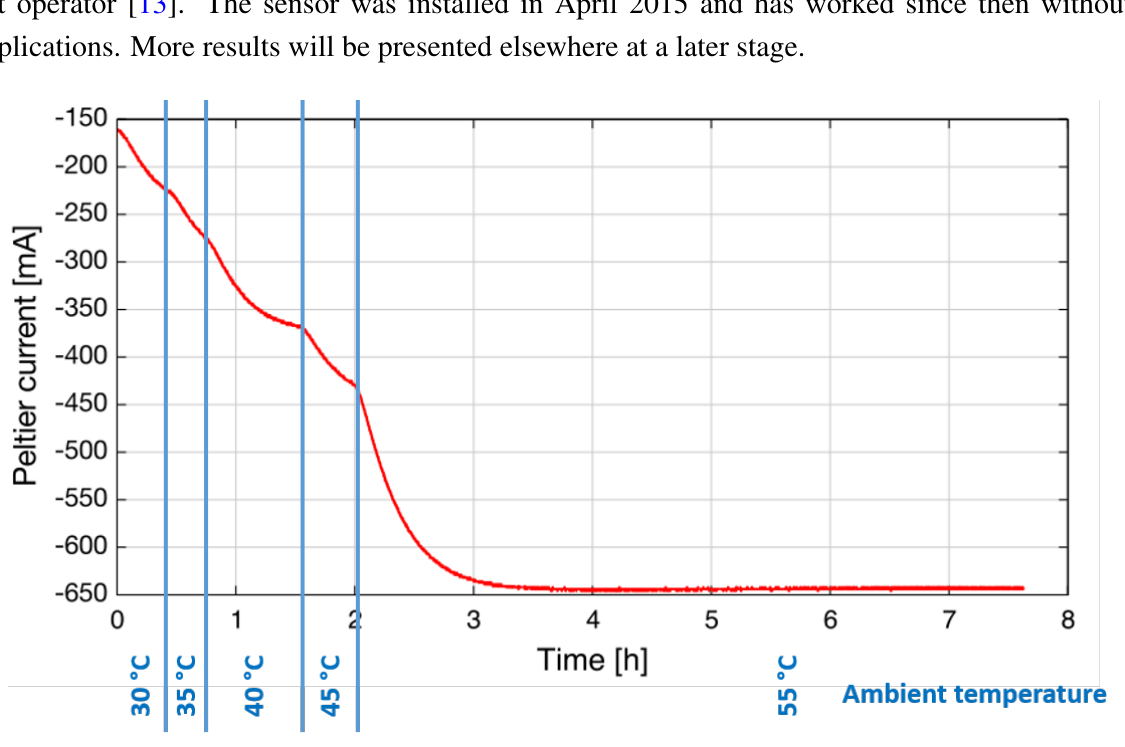
Figure 5. During the climate chamber test, the Peltier current that is necessary to stabilize the laser temperature was logged for different ambient temperatures, as indicated in blue at the